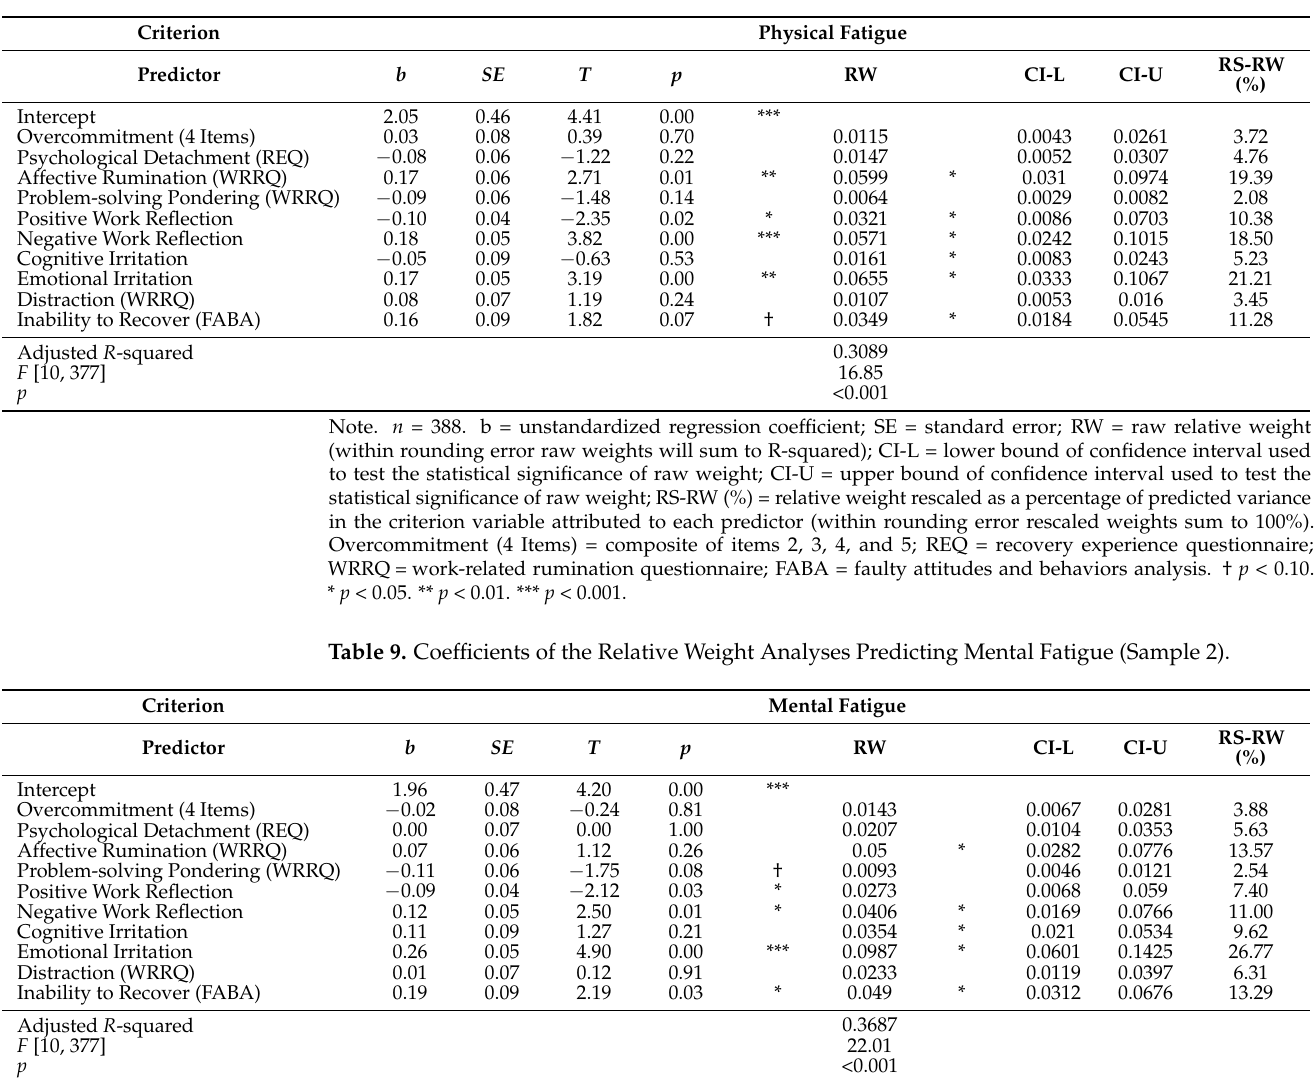
Table 8. Coefficients of the Relative Weight Analyses Predicting Physical Fatigue (Sample 2).